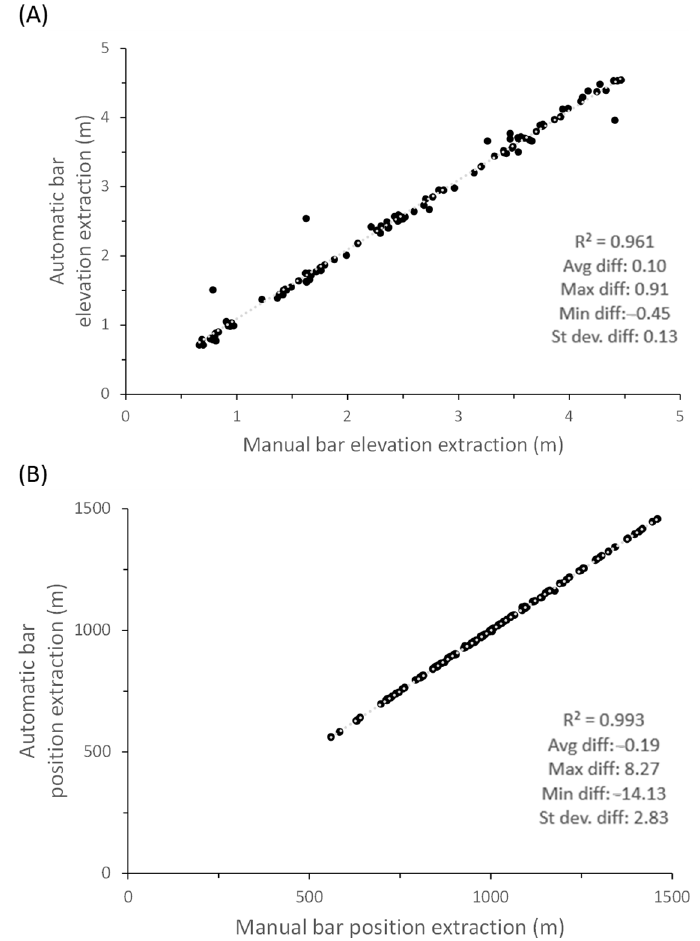
Figure 4. Comparison between automatic and manual extraction for ( A ) position and ( B ) elevation of bars (number of bar crest: 102).